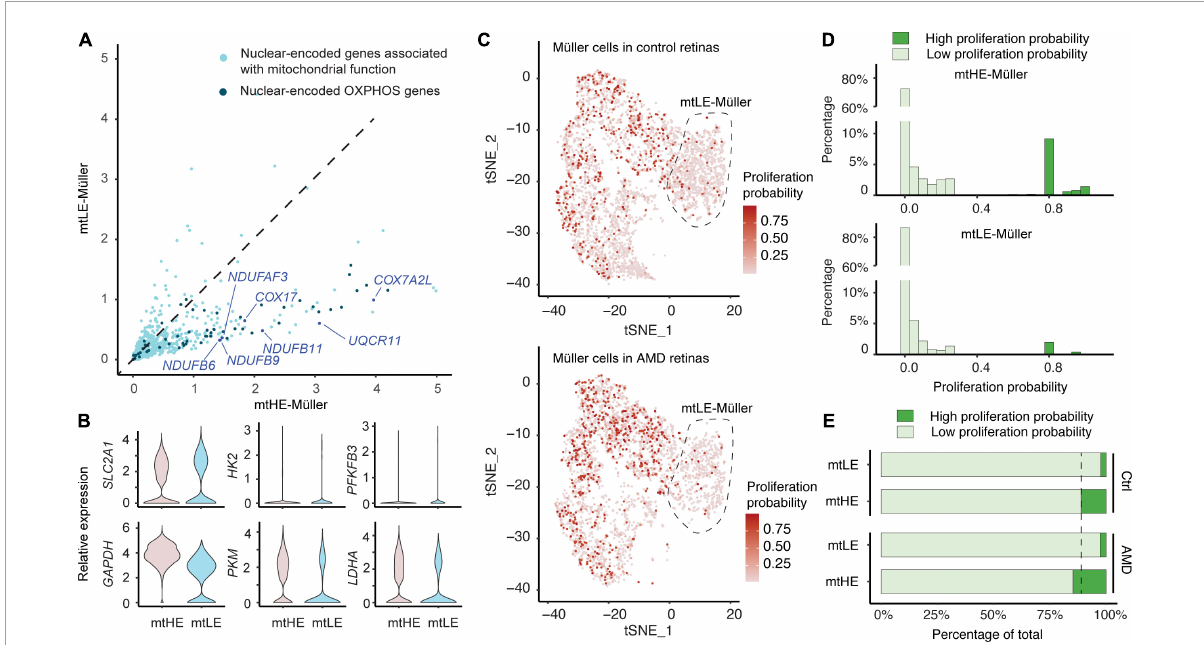
FIGURE2 Low expression of mtDNA (mtLE) Müller cells exhibit low energy production and proliferative ability. (A) The expressions of mitochondrial genes encoded by nuclear DNA (nDNA) in mtLE Müller cells are repressed. The nuclear-encoded oxidative phosphorylation (OXPHOS) genes are highlighted by dark blue. (B) Key glycolysis genes are not upregulated in the mtLE subcluster. (C) The proliferation probability (PP) of each Müller cell is predicted based on expressions of key cell-cycle genes. (D) The histogram statistics of PP show that mtLE Müller cells are less proliferative. (E) The high expression of mtDNA (mtHE) Müller cells, but not the mtLE subpopulation, become more proliferative under age-related macular degeneration (AMD)